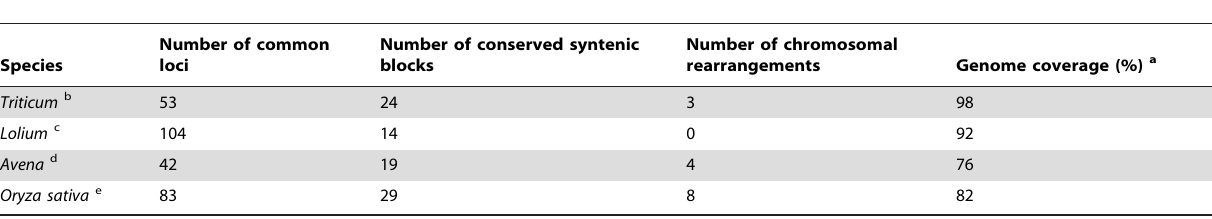
Table 2. Genome comparison between creeping bentgrass and the Triticeae, oat, ryegrass and rice based on common heterologous and homologous RFLP